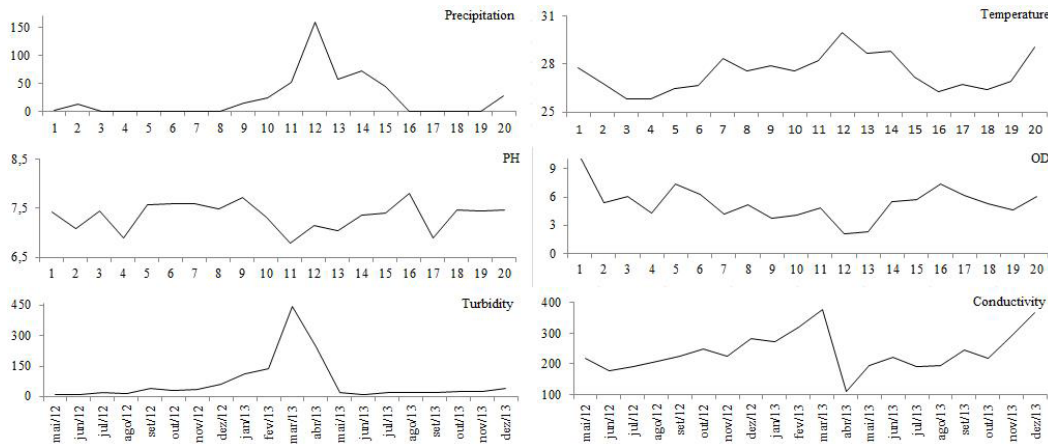
Figure 2. Precipitation data (mm), water temperature (°C), pH, conductivity (μS.cm-1), dissolved oxygen (OD) (mg / L), turbidity (UNT) collected from May 2012 to December 2013, at the Estação Ecológica do Seridó (ESEC-Seridó), Serra Negra, Rio Grande do Norte,